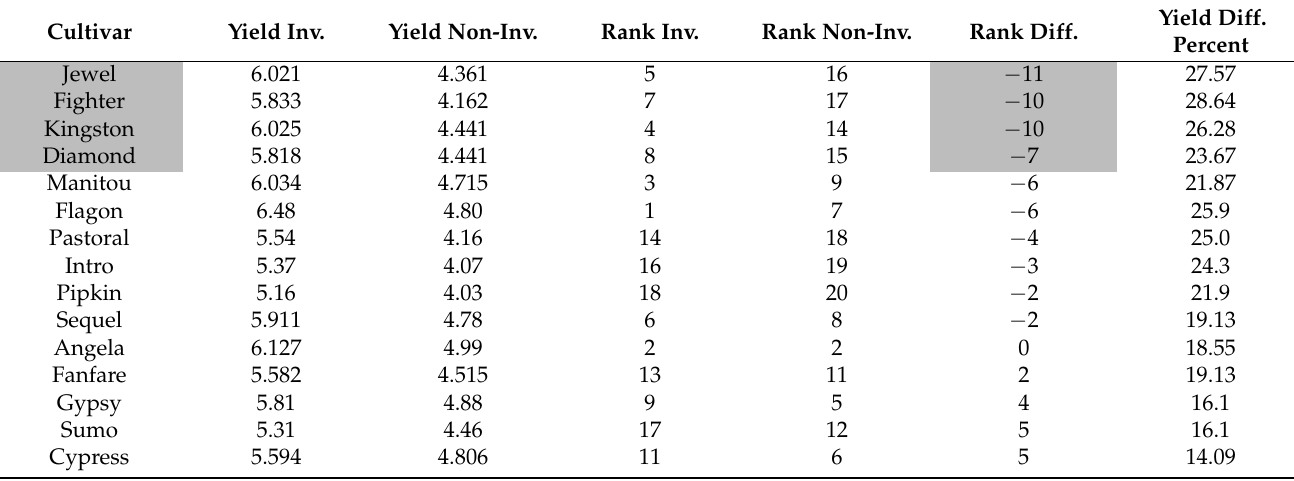
Yield Diff. Percent